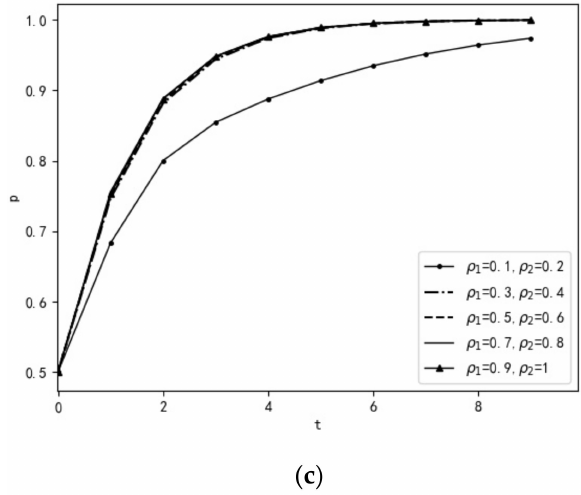
Figure 3. The influence of the probability of transformation from an ignorant individual to a latent individual on the tripartite strategy. ( a ) The impact of the probability of transformation of an ignorant individual to a latent individual on the local government. ( b ) The effect of the probability of transformation from an ignorant individual to a latent individual on the enterprises. ( c ) The impact of the probability of transformation from an ignorant individual to a latent individual on the